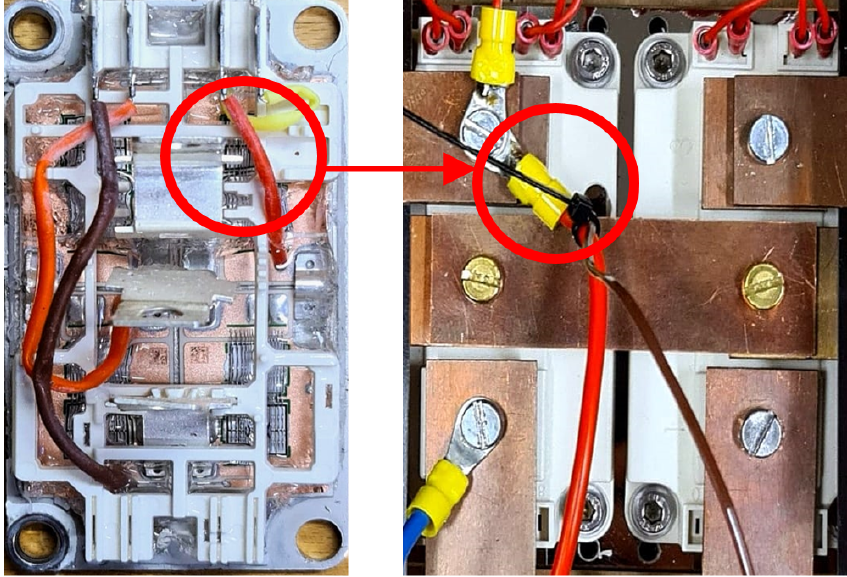
Figure 9. Half-bridge modules highlighting temperature